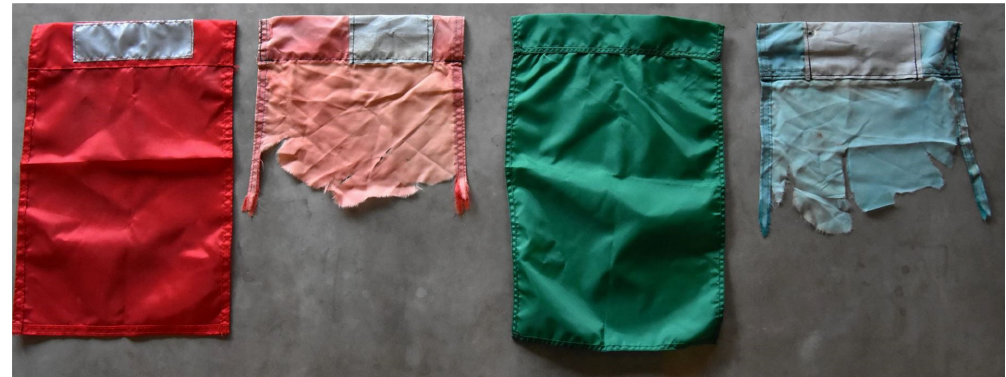
Figure 6. Marker flags used in Antarctica. Before being placed outside (left) and after they were retrieved (right). Photo credit: Evan Townsend (https://www.truesouthflag.com/flags-of-antarctica, last access: 25 May